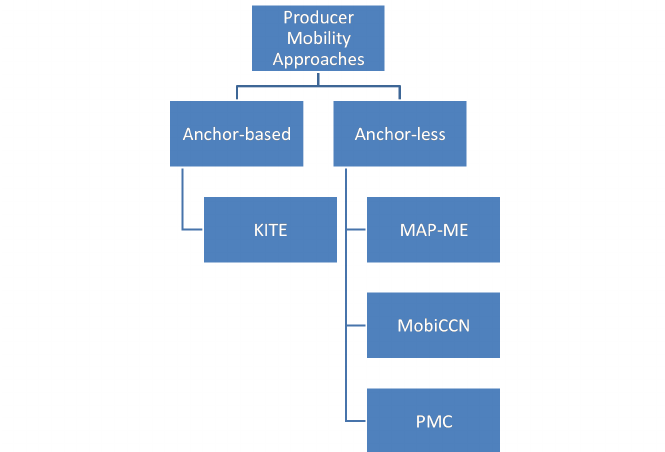
Figure 5. Categorisation of mobility management approaches that provide support for producer